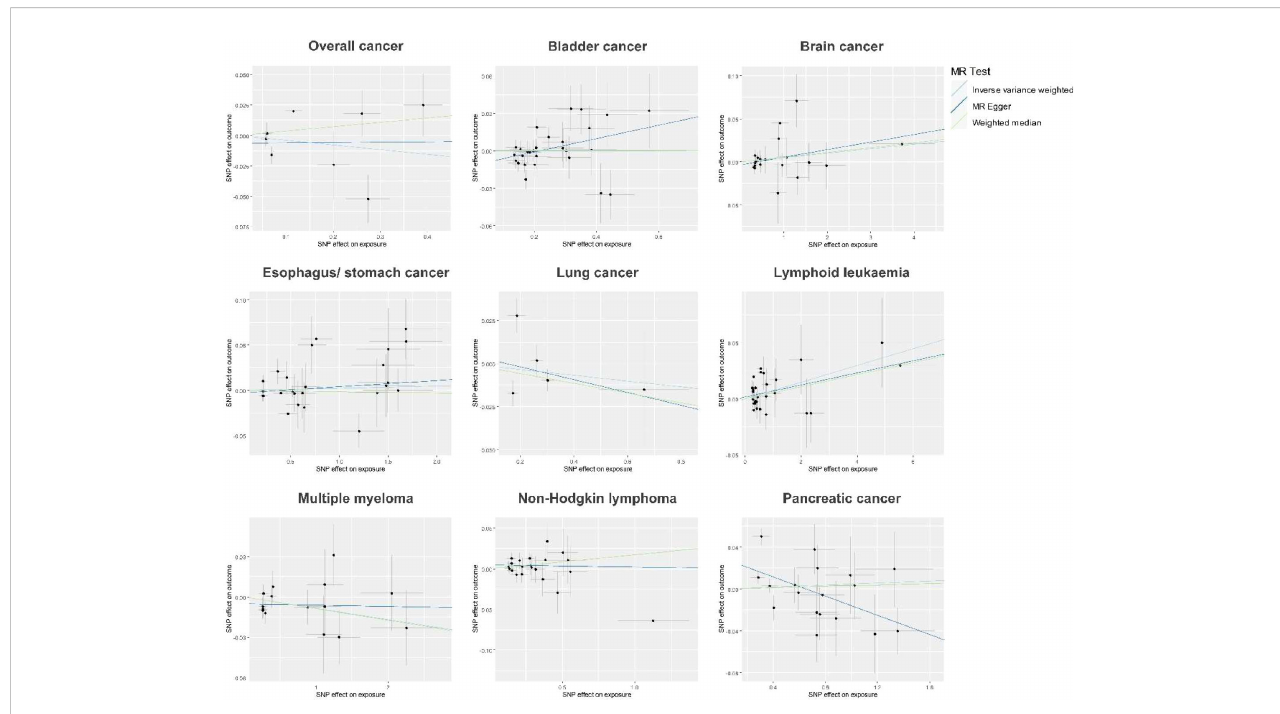
FIGURE 2 Scatter plots of the MR analyses showing the potential causal associations of site-speci fi c cancer with diabetes. MR, Mendelian randomization; SNP, single nucleotide